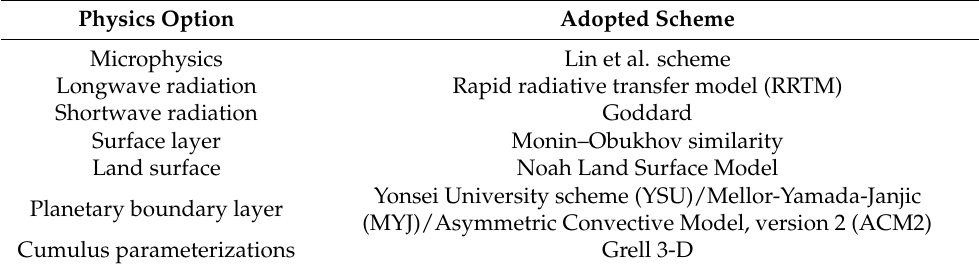
Table 1. Summary of physical and chemical options used in Weather Research and Forecasting regional air quality and chemistry model (WRF-Chem) simulations in this